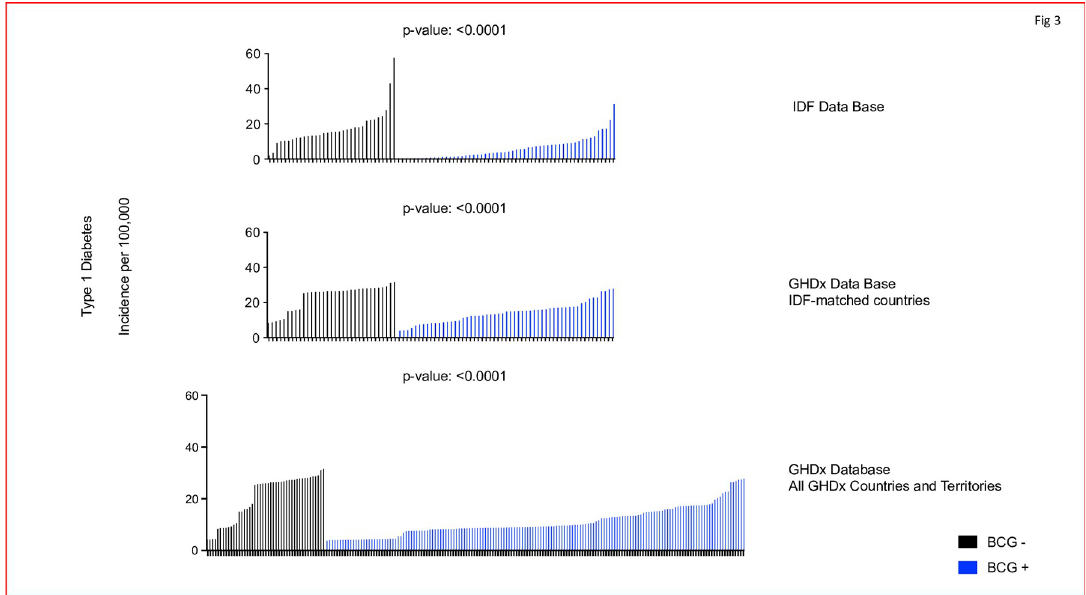
Fig 3. In global population data BCG neonatal vaccinations consistently correlate with reduced incidence of T1D. From the IDF list of countries, those with current BCG vaccination programs (blue lines) are observed to have significantly reduced incidence of T1D in children (p = < 0.0001). Countries with a mandatory BCG vaccination policy had an average of 65% reduced incidence. An almost identical trend was observed with a repeat search of T1D incidence for children in the GHDx database, using the same countries as the IDF database. This lends support to prevention based on the result that countries with a childhood BCG program are observed to have an average of 39% lower incidence for T1D (p = < 0.0001). Finally using all the countries and territories available in the GHDx dataset, we again observe the incidence of T1D in children is reduced by an average of 47% if they earlier received neonatal vaccinations of BCG (p = < 0.0001). A Mann-Whitney U test was used to compare the two groups of countries with (blue) and without (black) newborn BCG vaccinations based on the country-by-country policies. Black lines represent countries without BCG neonatal vaccination programs; blue lines represent countries with BCG vaccination programs. [N = 33 for BCG- countries, N = 56 for BCG+ for the IDF database] [N = 45 for BCG-, N = 159 for BCG+ countries and territories in the GHDx database]. Notation of the countries are in Table